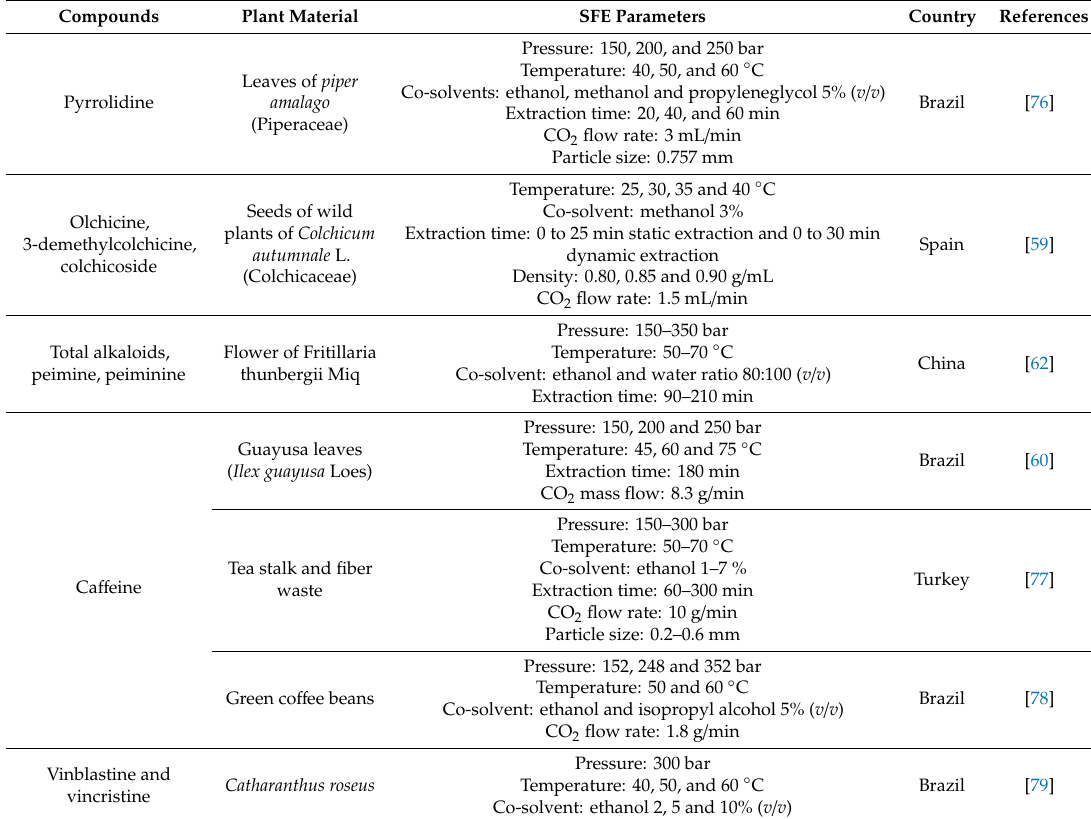
Table 4. Application of supercritical CO 2 for the separation of alkaloids from